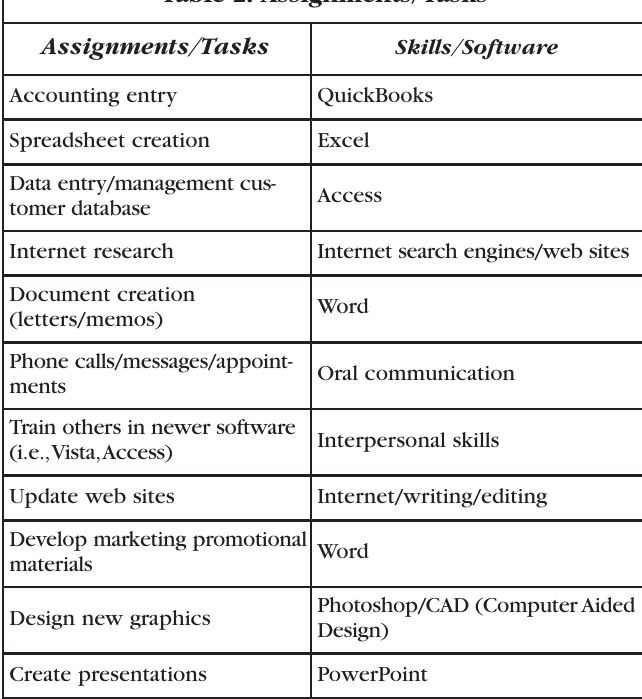
Table 2. Assignments/Tasks Assignments/Tasks